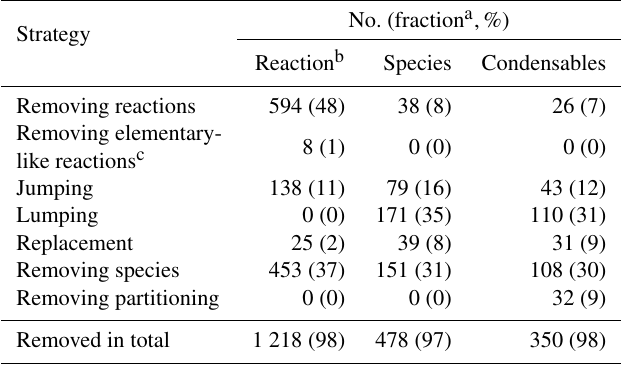
Table 7. Reduction accomplished per each reduction strategy dur- ing the building process of the Rdc.